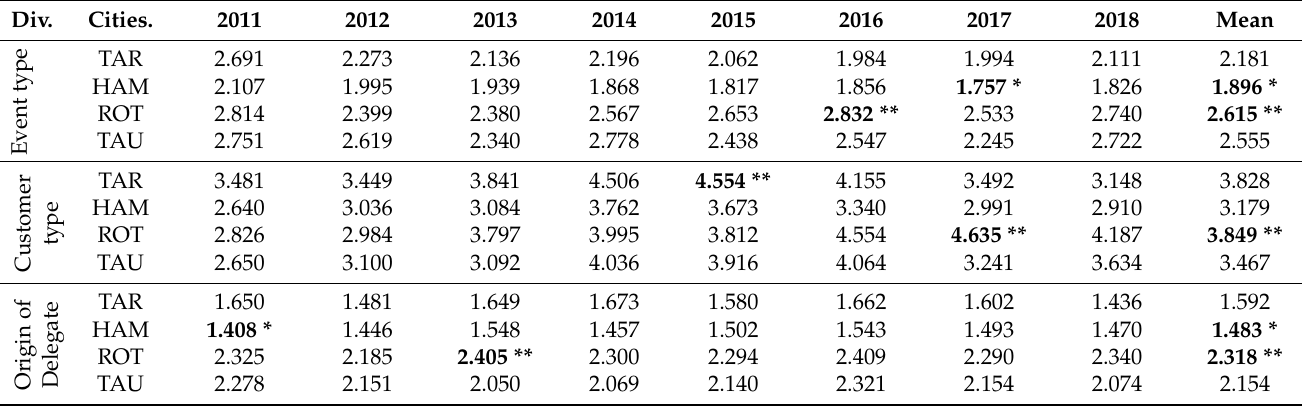
Table 2. Niche breadth by the resource dimensions.